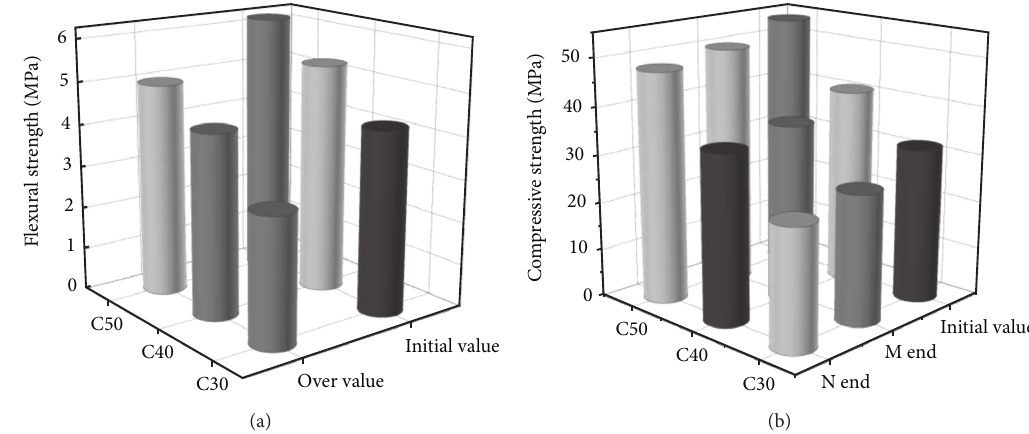
Figure 4: Change of mechanical properties of concrete. (a) Flexural strength value. (b) Compressive strength value.